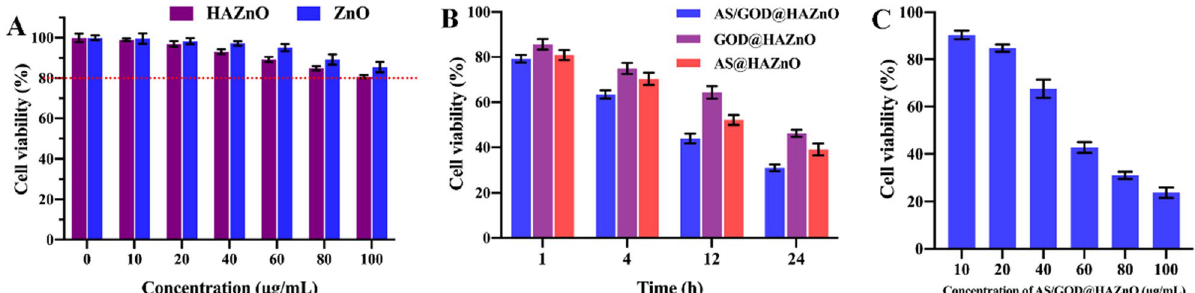
Figure 7. ( A ) Cell viability of 4T1 cells after treated with ZnO and HAZnO NPs for 24 h; ( B ) Cell viability of 4T1 cells after treated with AS/GOD@HAZnO, GOD@HAZnO, and AS@HAZnO NPs at different timepoints; ( C ) Cell viability of 4T1 cells after treated with different concentrations of AS/GOD@HAZnO for 24 h (10 ~ 100 μg/mL). Data are presented as mean ± SD, n =